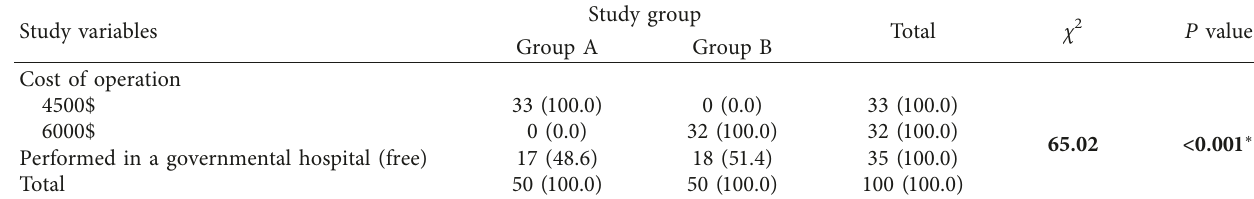
Table 7: The association between the cost of operation and study